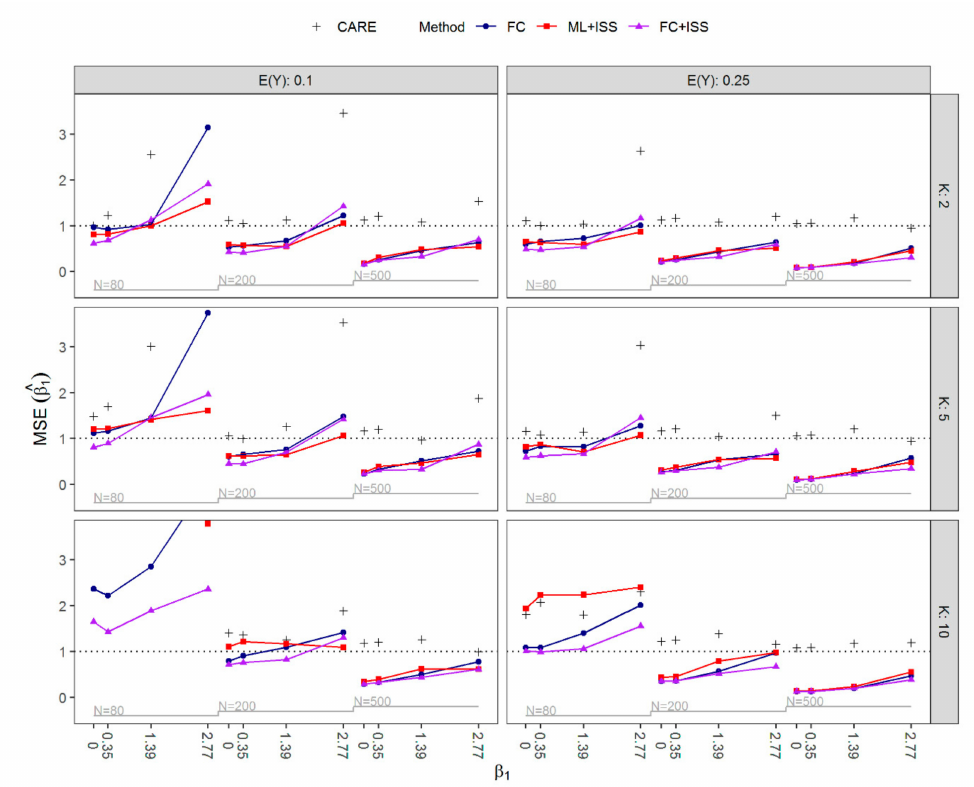
Figure 3. Nested loop plot of the mean squared error (MSE) of ˆ β 1 by the expected value of Y , E ( Y ) ∈ { 0.1, 0.25 } , the number of covariates K ∈ { 2, 5, 10 } , the value of β 1 ∈ { 0, 0.35, 1.39, 2.77 } , and the sample size N ∈ { 80, 200, 500 } for all simulated scenarios. In addition, CARE as defined in Equation (4) is shown by + , where CARE > 1 suggests that ML + ISS is a less e ffi cient estimator than FC. The results for ML + ISS for E ( Y ) = 0.1, K = 10 and N = 80 are outside of the plot range. The CARE for some scenarios with E ( Y ) = 0.1 and N = 80 also lies outside of the plot range. FC, Firth’s correction; ML + ISS, maximum likelihood combined with the increasing sample size approach; FC + ISS, Firth’s correction combined with the increasing sample size approach; CARE, cost-adjusted relative e ffi